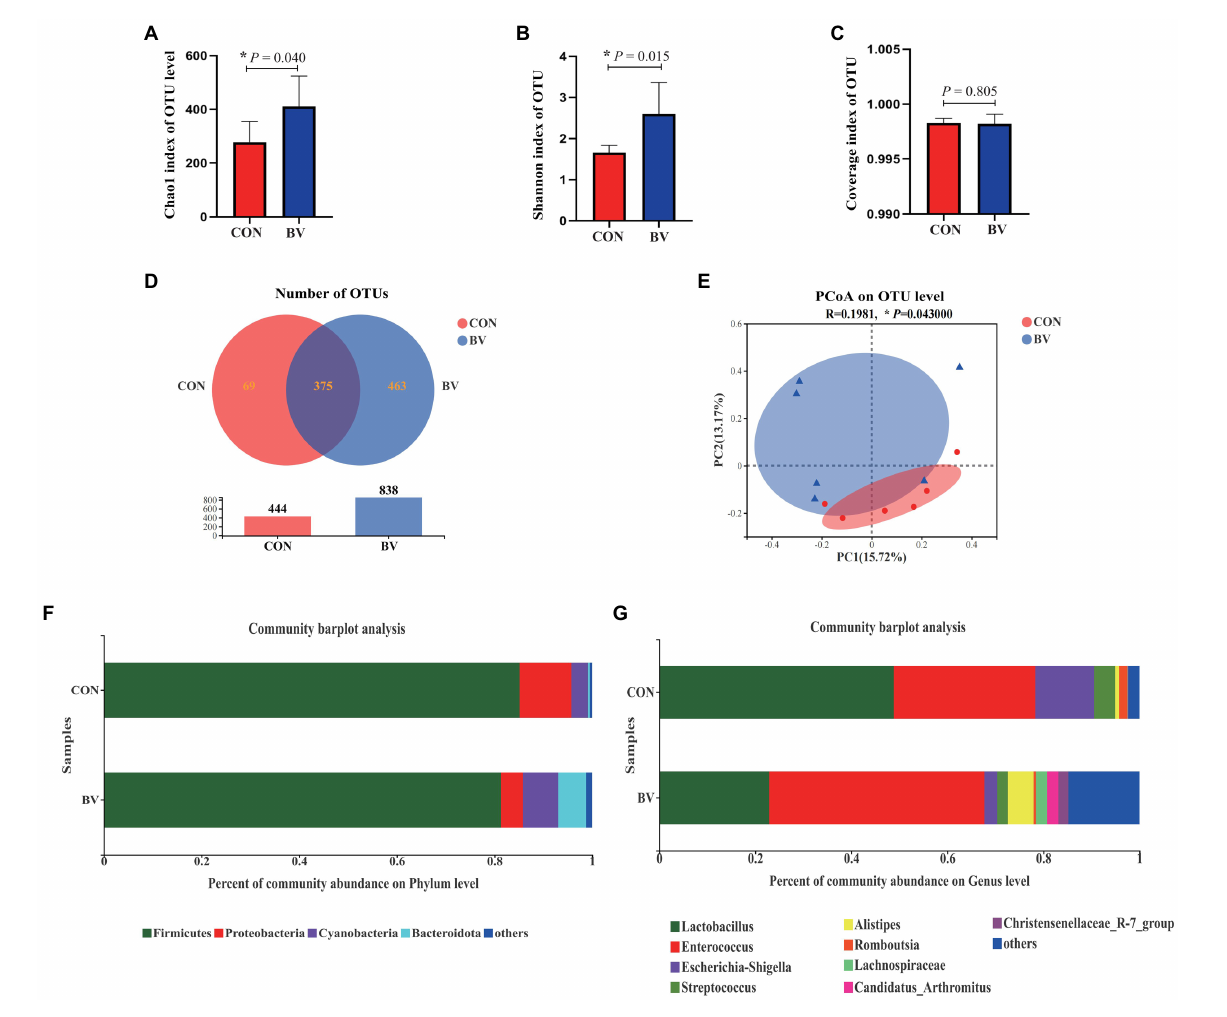
FIGURE 6 Effect of Bacillus velezensis LB-Y-1 on the ileal microbial diversity of broilers ( n = 6). (A) Chao1 index of OUT level. (B) Shannon index of OUT level. (C) Coverage index of OUT level. (D) Number of OTUs. (E) β -diversity was estimated by the PCoA on OUT level. (F,G) The relative abundance of bacteria at the phylum and genus levels, respectively. Values are presented as Mean ± SEM, the values having superscript (*) were significantly different, *0.01 < p < 0.05; ** p ≤